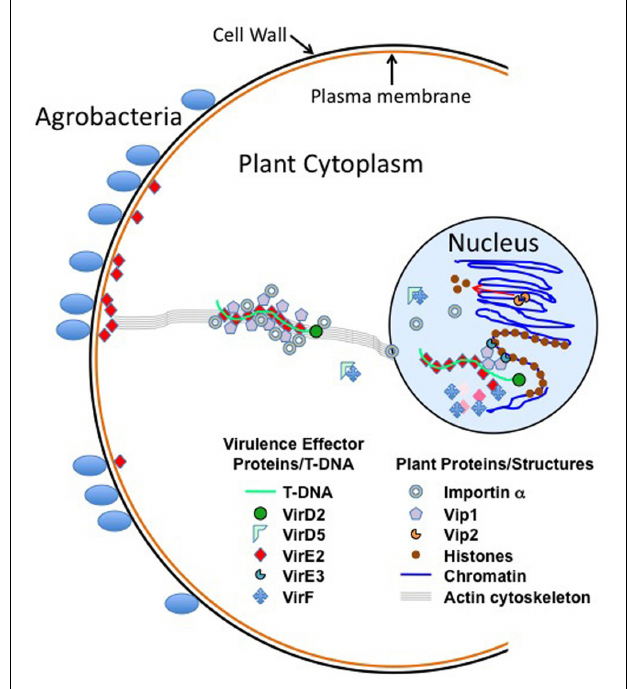
FIGURE 4 | Model ofT-DNA movement through the plant cell, and the proteins and structures with which it interacts. This model assumes that theT-strand/VirD2/VirE2T-complex exists in a plant cell as hypothesized. Sub-cellular movement ofT-complexes and/orVirulence effector proteins may utilize the actin cytoskeleton, as shown.